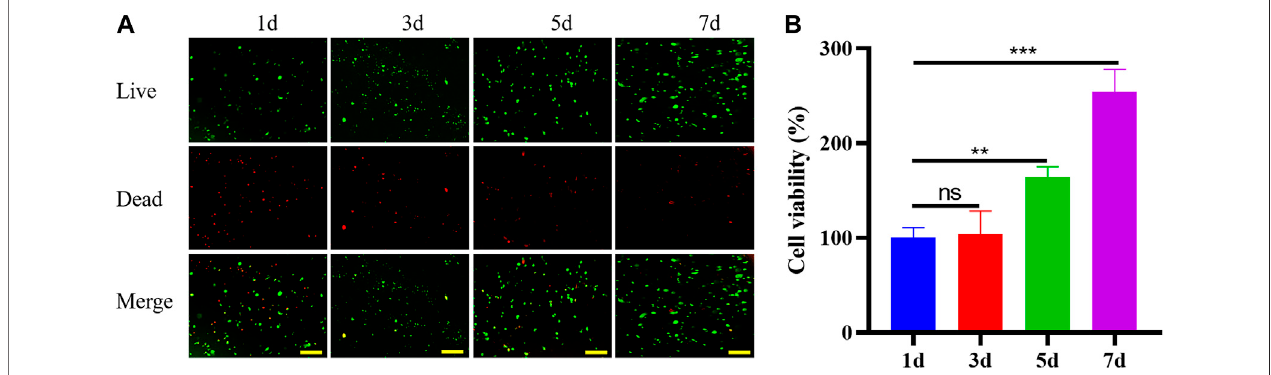
FIGURE 3 | Staining of live (green fl uorescence) and dead (red fl uorescence) BMSCs in scaffolds at days 1, 3, 5 and 7 (A) (bar = 200 μ m). Viability of BMSCs in scaffolds at days 1, 3, 5 and 7 (B)